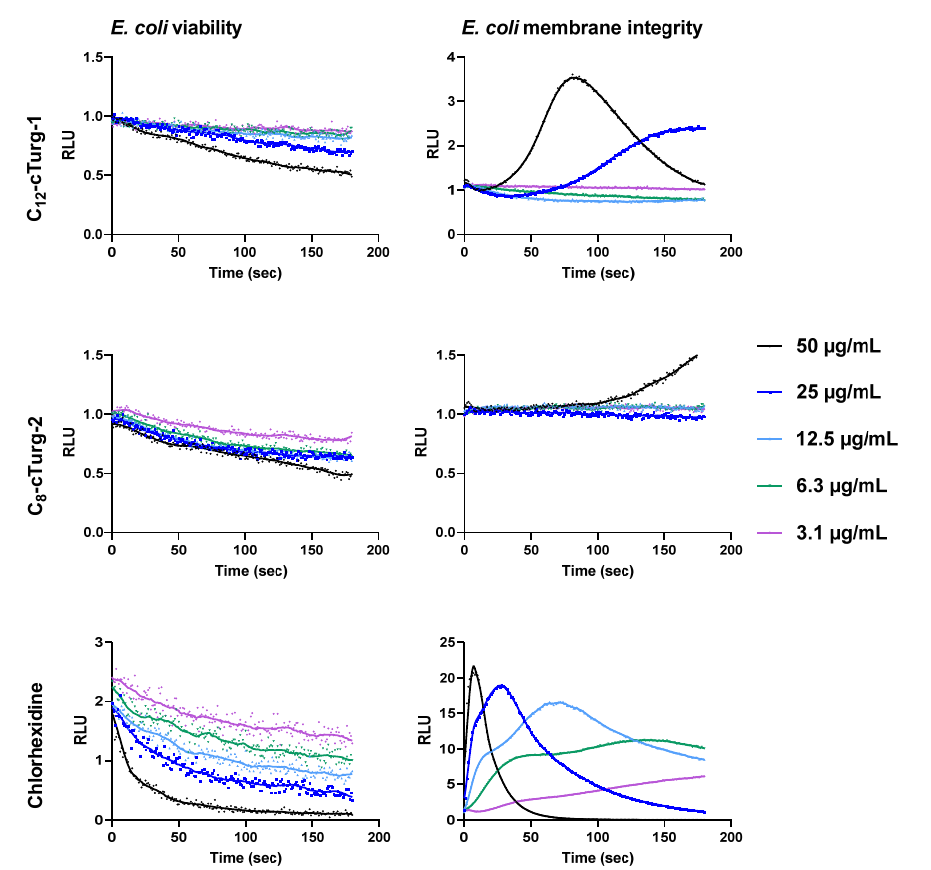
Figure 4. Effects of C 12 -cTurg-1 , C 8 -cTurg-2 and chlorhexidine on the kinetics of viability ( left ) and membrane integrity ( right ) in E. coli K12 . Light emission normalized to the untreated water control is plotted as relative luminescence emission (RLU) over time (seconds). After addition of the bacterial inoculum (mixed with 1 mM D-luciferin in the membrane assay) to the wells, preloaded with lipopeptides, the light emission was measured each second for three min. Each colored line represents the total 180 s data points (mean of three independent measurements) from the assay at different concentration of the lipopeptides.